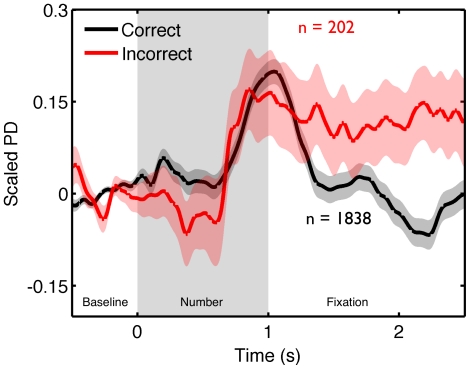
Evoked changes in PD are abnormal during encoding failures in the WM task.Scaled PD prior to correct and incorrect responses in the WM task from Experiments 2 & 3. Twenty six participants passed the quality control cut-offs and made one or more mistakes in the WM task. Three participants were excluded due to PD values greater than 3 SD above the population mean in one or more bins, leaving a total of 23 valid cases. Time courses for each trial for each subject, locked to pre-probe stimuli, were calculated for correct and incorrect responses during the WM task. Values were averaged in ten 250 ms bins and compared using a 2×10 ANOVA with factors of Accuracy [2 levels] and Epoch [10 levels]. Experiment was included as a between participants factor. This analysis yielded the expected Accuracy X Epoch interaction (F (9, 189) = 4.3, p<.01, η2 = .17). Contrast analysis indicated that the difference in the PD dynamics between correctly and incorrectly encoded stimuli fitted a cubic pattern that accounted for approximately 24% of the difference in accuracy (F (1, 21) = 7.4, p<.05, η2 = .24). This analysis confirms that the difference between situations when external task relevant information was and was not encoded can also be attributed to differences in the evoked pupillary response (P2). No other main effect of accuracy, experiment or their interactions reached statistical significance.